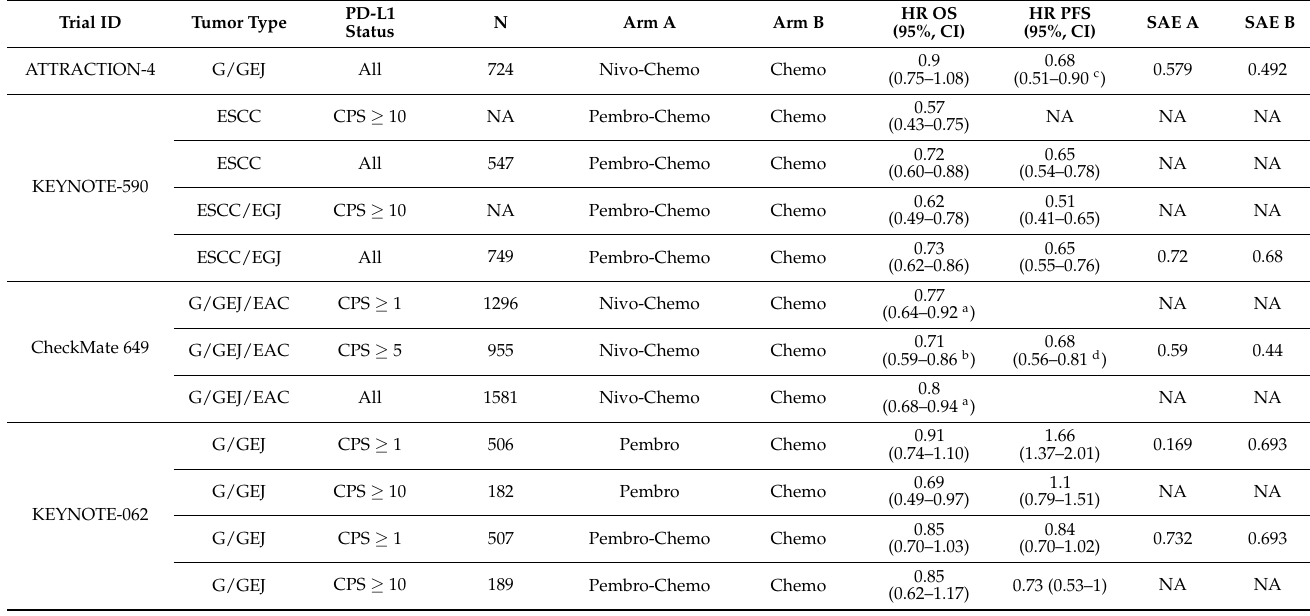
Table A2. Outcomes according to subgroups in the first-line